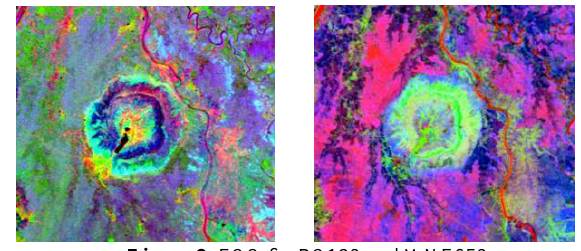
Figure 2. FCC for PC123 and MNF653